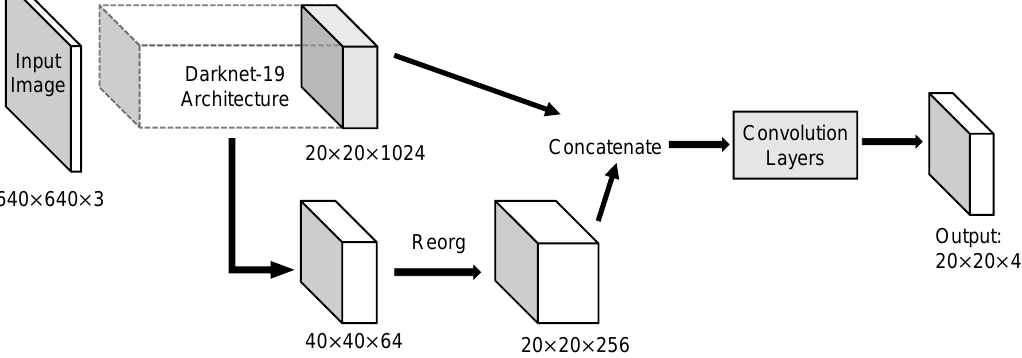
Figure 4. Architecture of YOLOv2 model. Concatenation of coarse-grained feature map and fine-grained feature map helps to combine more features to improve detection. With anchors set to 6, the output became larger than YOLOv2.